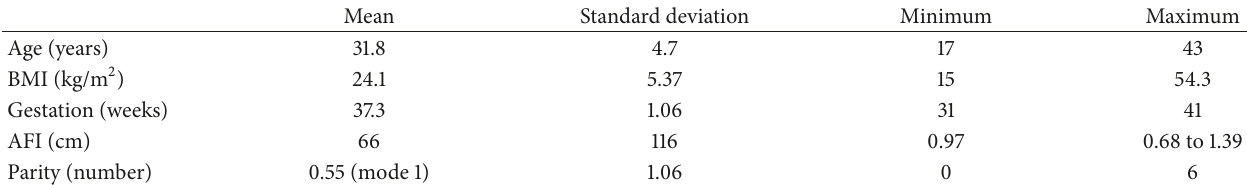
Table 1: Demographic data.